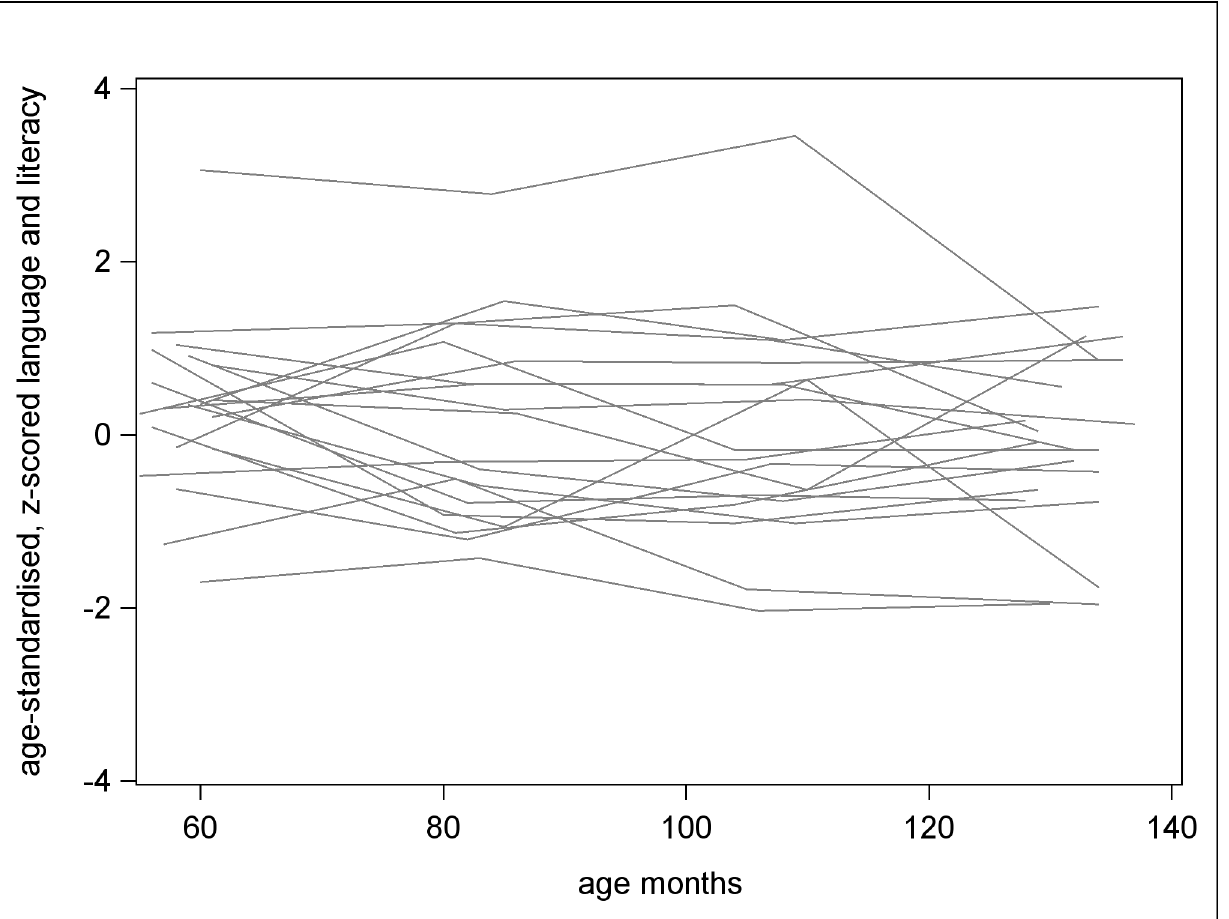
Fig 1. Variation in language and literacy at ages 4, 6, 8 and